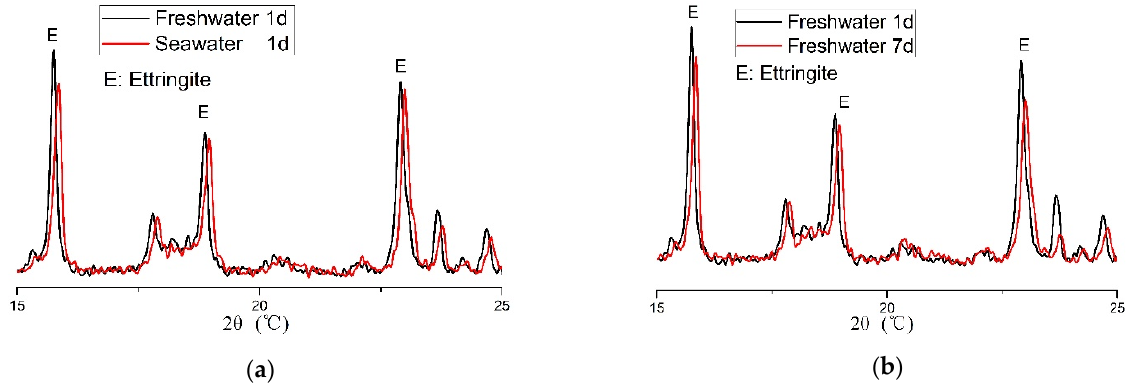
Figure 10. XRD patterns of CSA cement mixed with freshwater and seawater ( a ) cured for 1 d or ( b ) cured for 7 d.